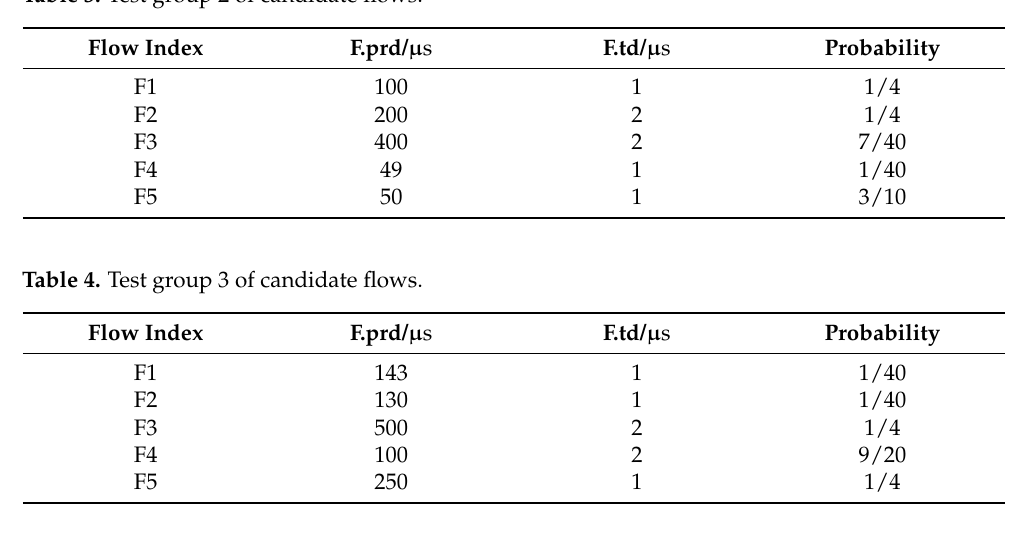
Table 3. Test group 2 of candidate flows.